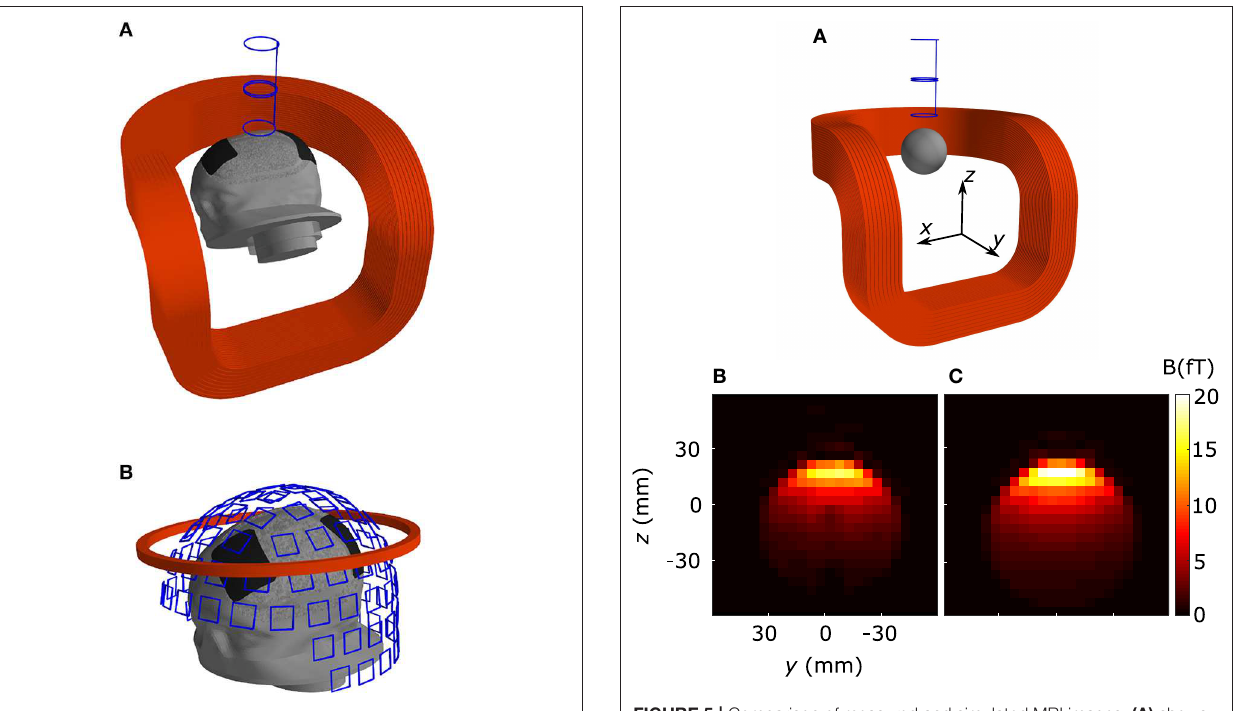
FIGURE 4 | Geometries of the single-channel MRI setup at PTB (A) and the multi-channel MRI setup at Aalto (B) . The illustrations include the polarizing coil (red), the receiver coils of the sensors (blue), the head model (gray), and the stimulation electrodes (black).